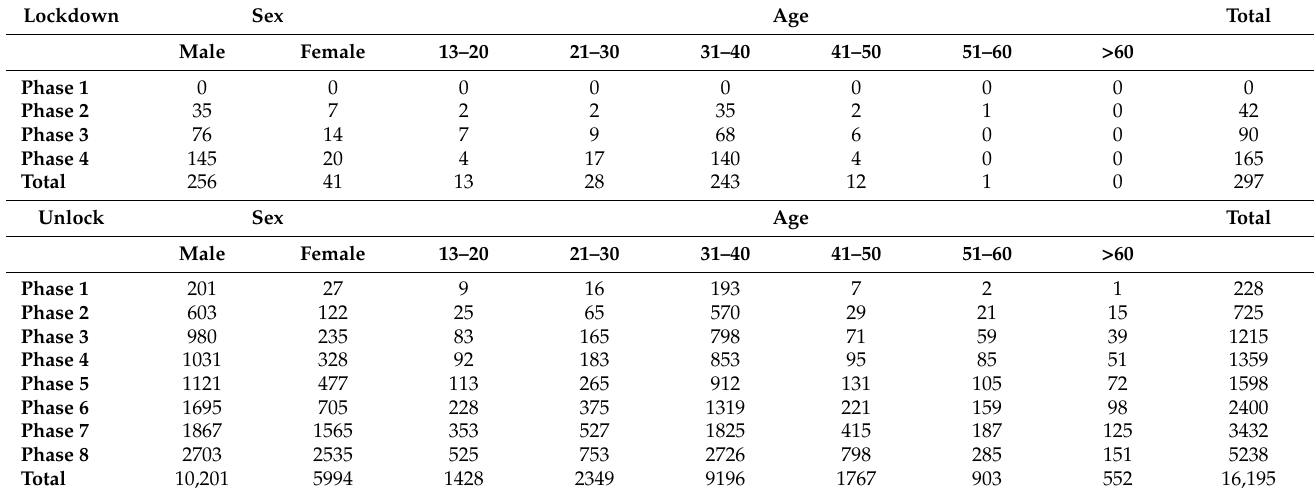
Table 2. Demographic data with respect to the sex and age of patients that visited the dental school during the different lockdown and unlock phases.